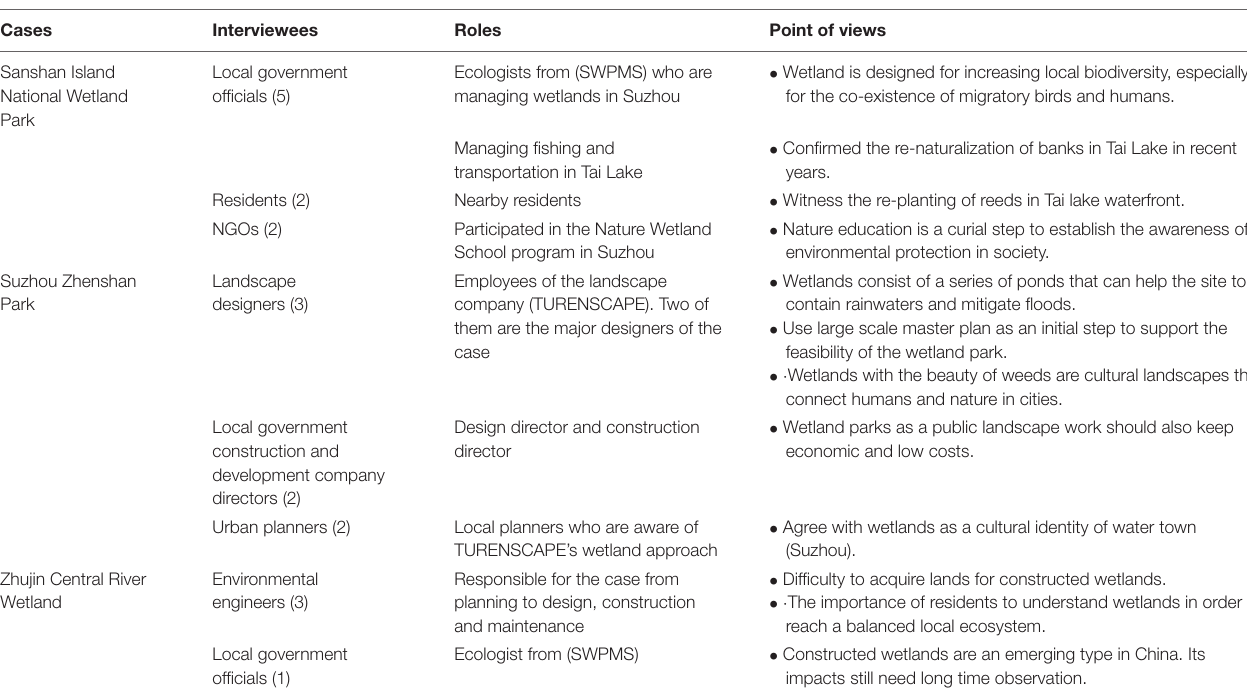
TABLE 1 | Summary of data collection (Made by